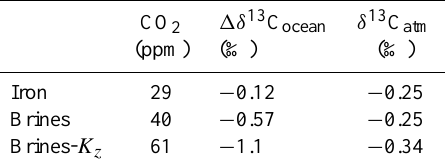
Fig. 3. Evolution of oceanic 1δ 13 C ocean with a constant climate for three mechanisms: (a) iron fertilization, (b) sinking of brines and (c) sinking of brines and interactive vertical diffusion. Table 1. Amplitude of change between the beginning and the end of the simulations under a constant glacial climate as observed on Figs. 2, 3 and 4. “Iron” corresponds to iron fertilization, “Brines” to the sinking of brines, and Brines- K z to the sinking of brines and interactive diffusion.